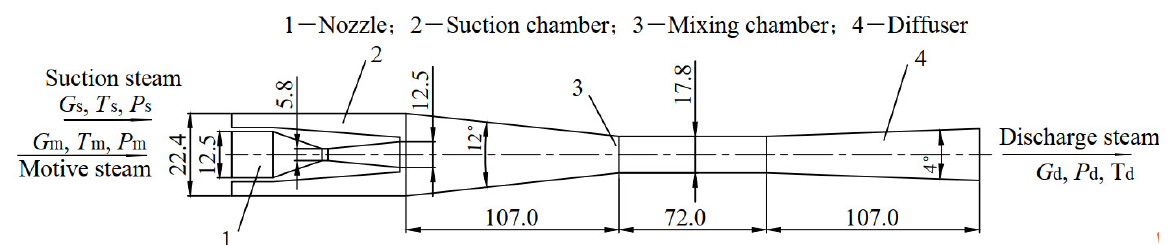
Figure 1. Structure and size of the steam ejector. Table 1. Computation parameters.